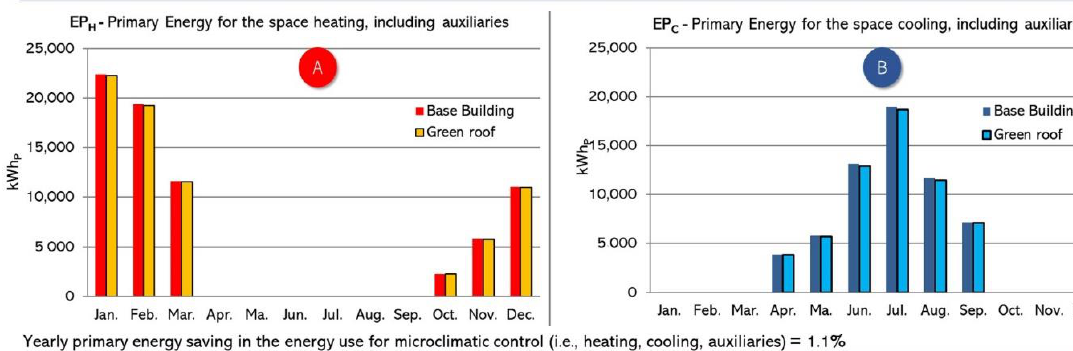
Figure 9. HVAC Heating and cooling primary energy demand, before and after the green roof addition.